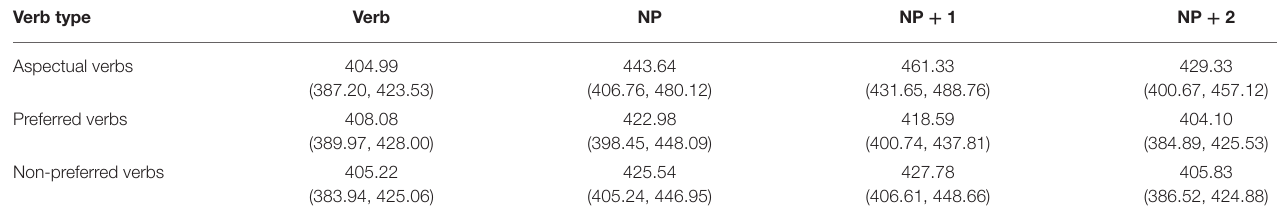
TABLE 2 | Mean reading times (in milliseconds) at each region, and difference-adjusted 95% (percentile) mixed-effect-model-based intervals (Politzer-Ahles,